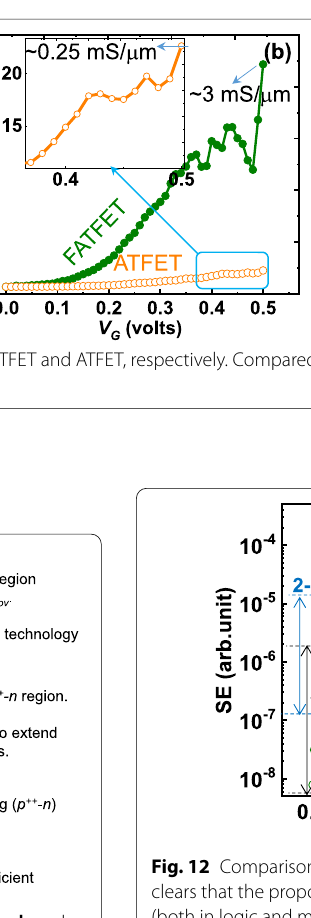
Fig. 10 Comparative advantages of a proposed FATFET over b and c earlier reported structures in terms of tunneling rate and device flexibility for future technology nodes